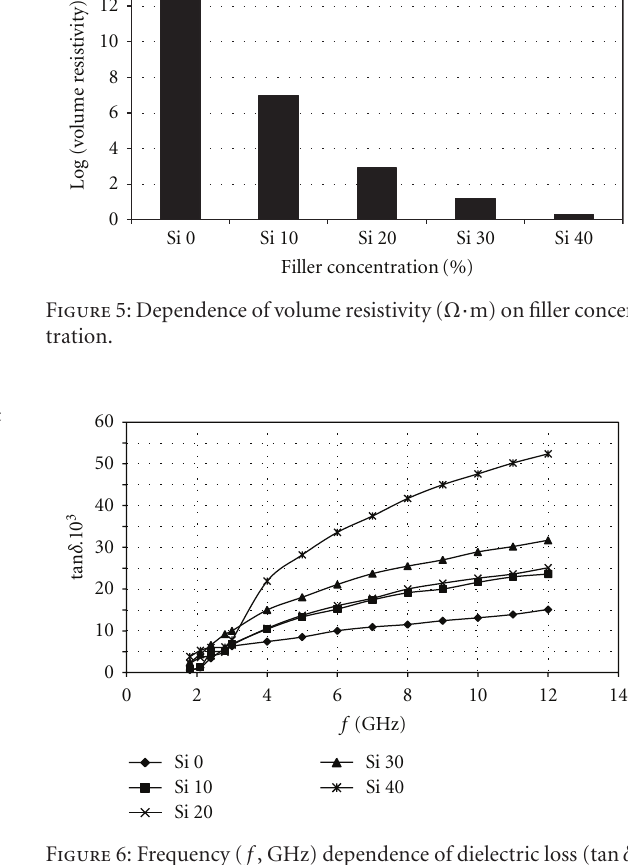
Figure 6: Frequency ( f , GHz) dependence of dielectric loss (tan δ · 10 3 ) at various filler content in the